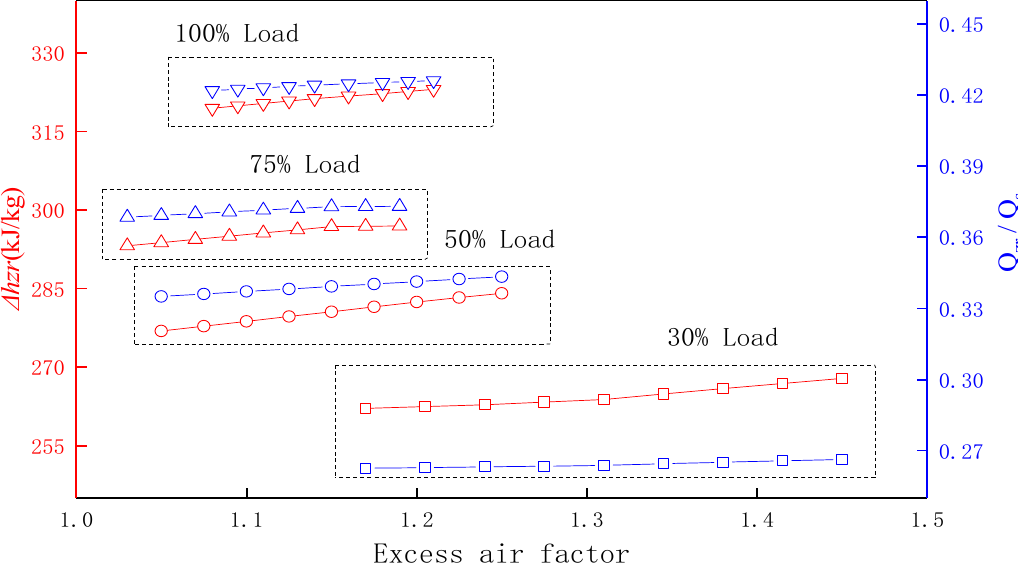
Figure 10. Influence of excess air factor on FGR under different loads of reference system.